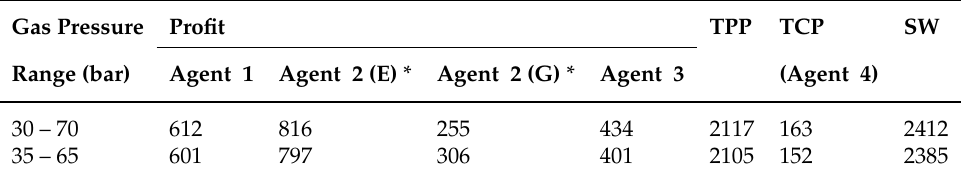
Table 7. Case study 2: profits and social welfare ($ thousand) for two sets of gas pressure limits (Max TPP